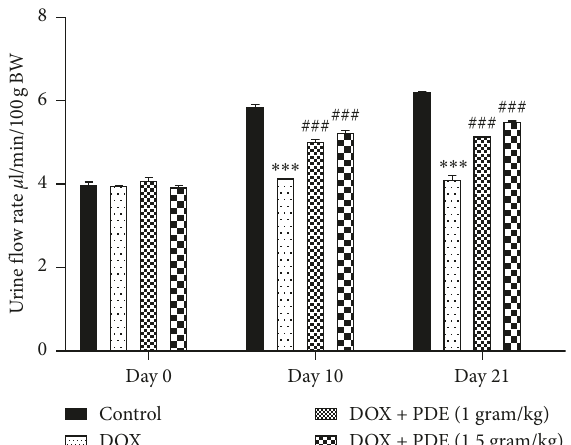
Figure 3: Effects of PDE on urinary flow rate in DOX-induced changes in rats. The values are mean ± SEM ( n � 6). Statistical analysis was done through two-way analysis of variance (ANOVA) followed by Bonferroni post hoc test. For determination of p values, DOX is compared with the control group, and treatment groups were compared with the DOX group. The results are considered significant if p < 0 . 05. ∗∗∗ p < 0 . 001 vs. control and ### p < 0 . 001 vs. DOX.